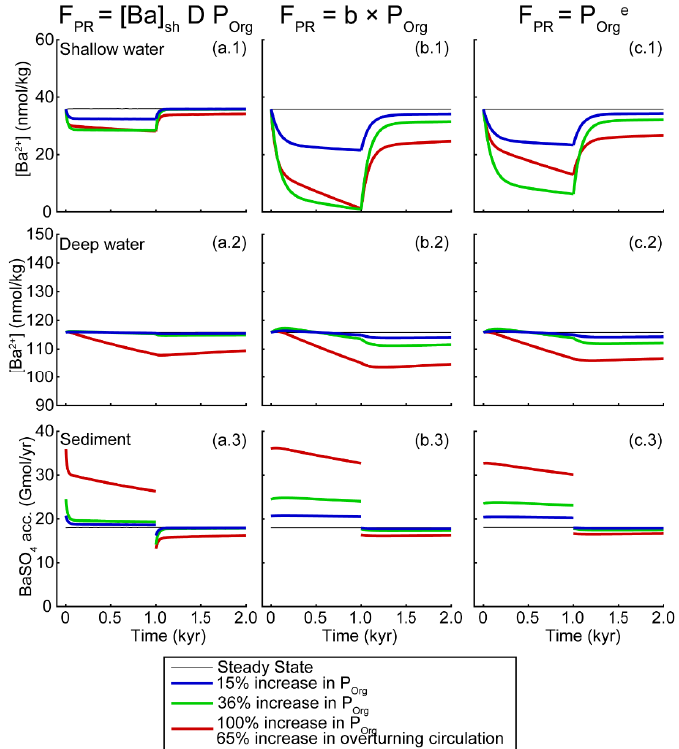
Figure 6. Box model results from Dickens et al. [27] compared with new results with two equations to describe F PR . The three columns ( a–c ) show results using different relationships of F PR . The three rows ( 1–3 ) show the dissolved concentration of Ba 2+ in surface water (top; a.1, b.1, c.1 ), the dissolved concentration of Ba 2+ in deep water (middle; a.2, b.2, c.2 ), and the accumulation of barite (BaSO 4 ) in the sediment (bottom; a.3, b.3, c.3 ). The left column shows results using the relationship for F PR described by Dickens et al. [27] ( a.1, a.2, a.3 ). The middle column (shows results using a linear